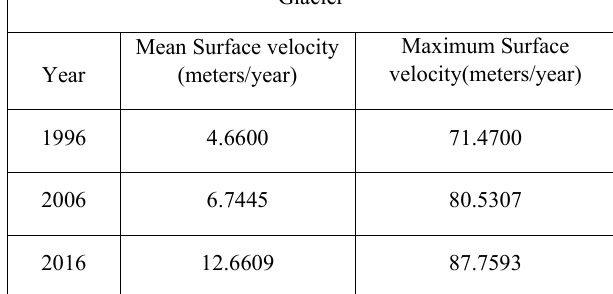
Table 2. Summary of Mean Surface Velocity and maximum surface